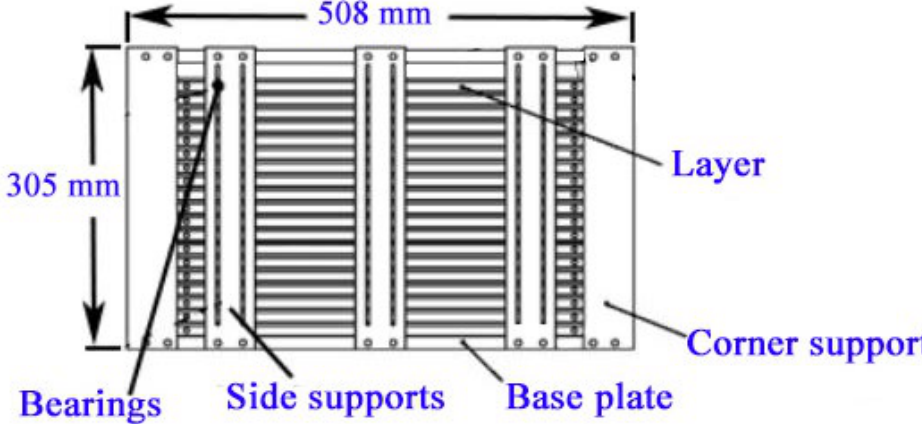
Figure 9. General view of the laminar box (From [27]; modified).